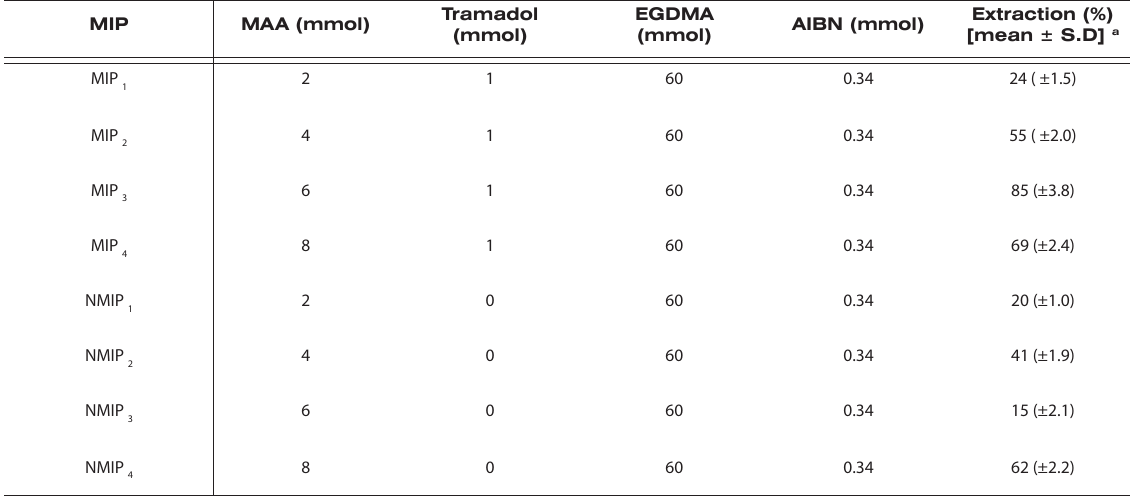
Table 1. Compositions of the polymer’s extraction.